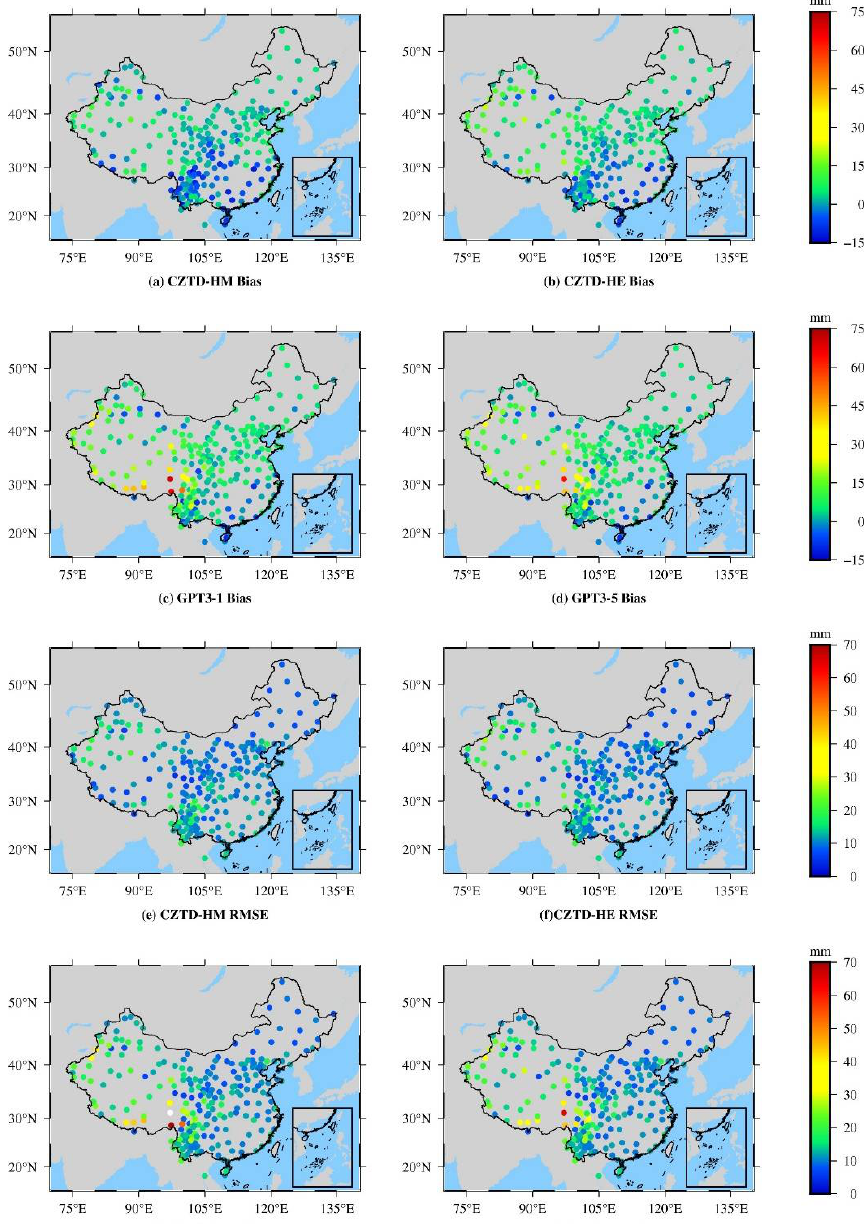
Figure 6. Distribution of bias and RMSE of spatial interpolation for GGOS gridded ZTD compared with GNSS data.